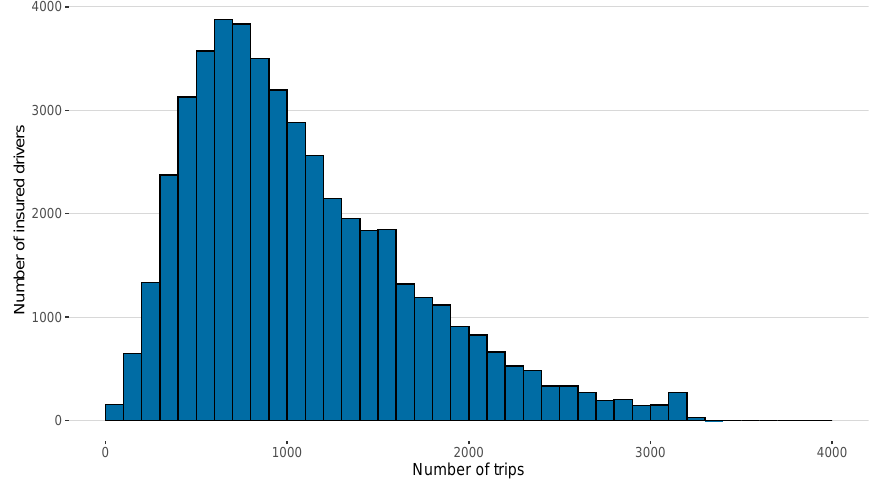
Figure 3. Histogram of the number of trips Each band has a length of 100 trips.